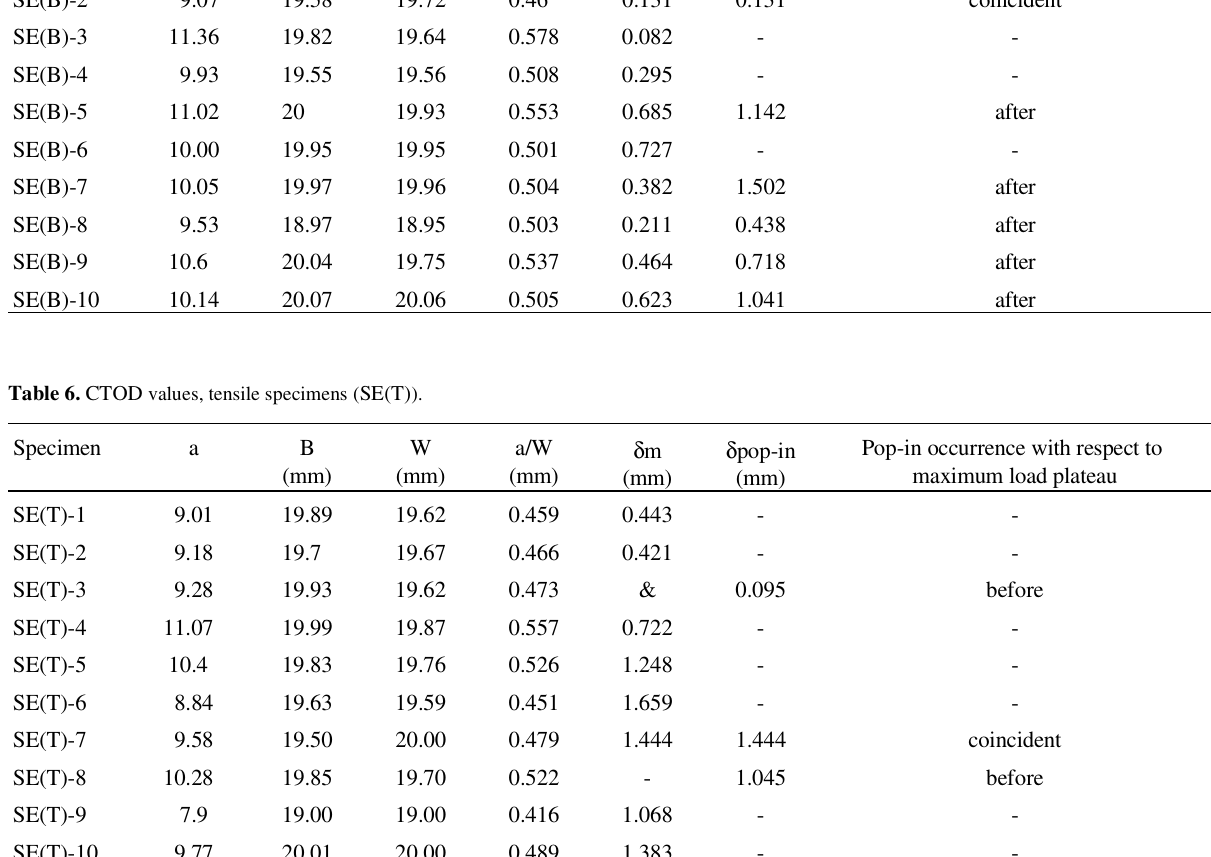
Table 5. CTOD values, three point bending specimens ( SE ( B ) ). Specimen